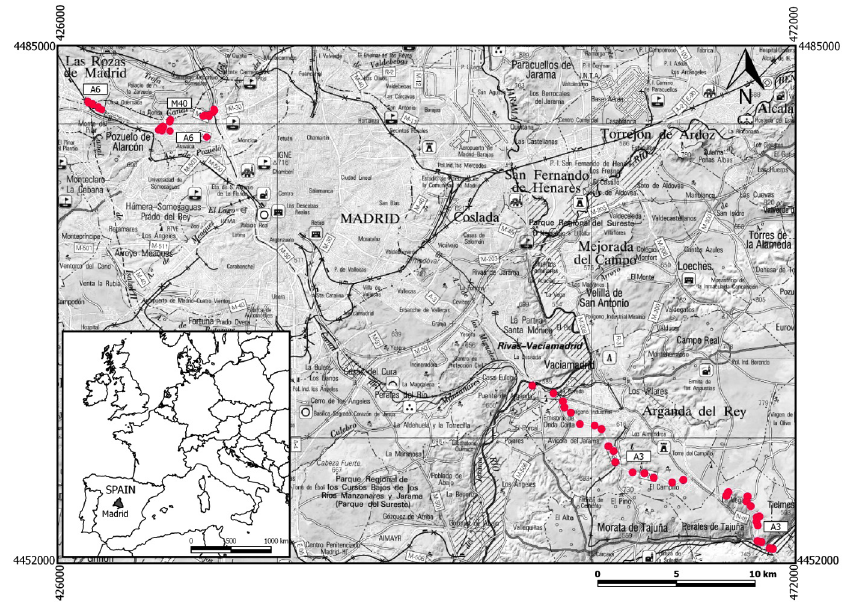
Figure 1. Location of the studied road slopes (UTM coordinates,